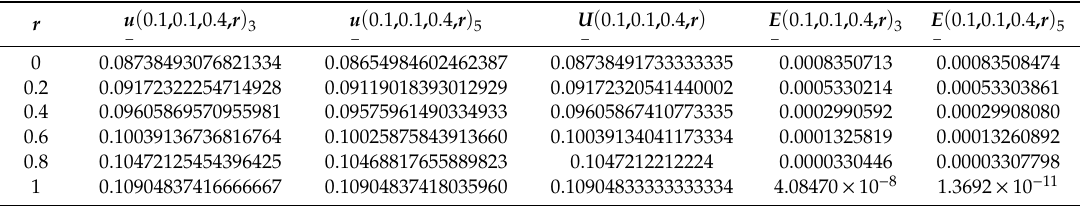
Table 3. Solution and accuracy of third and fifth order double parametric fuzzy HPM solutions for Equation (24) at t , x = 0.1 and b = 0.4 for all r ∈ [ 0,1 ] .